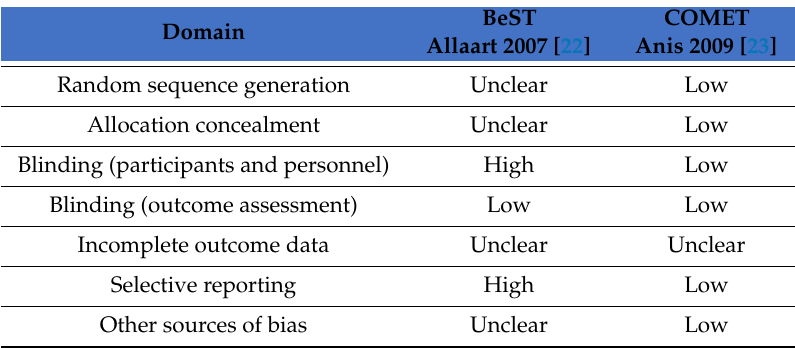
Table A2. Risk of bias in randomized controlled trials included in systematic